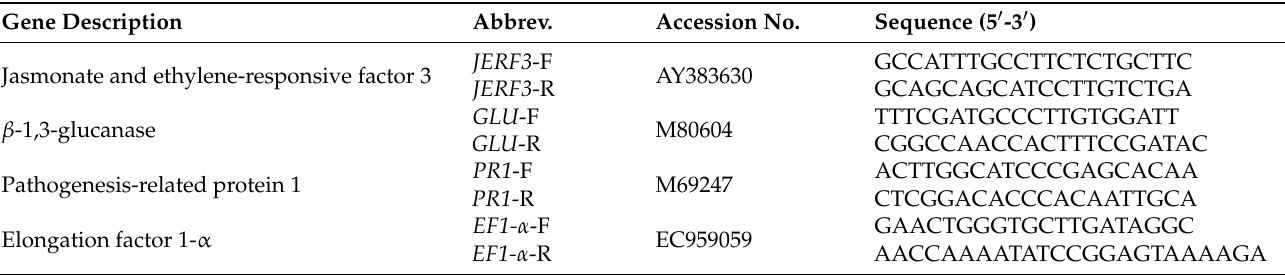
Table 1. Primer sequences used in the molecular